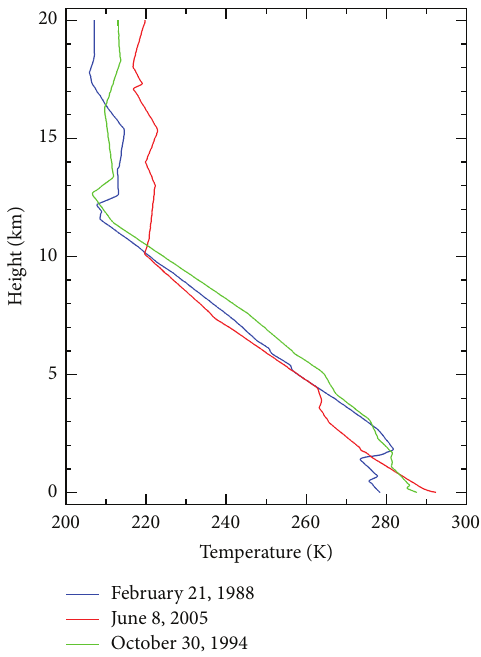
Figure 1: Three temperature profiles recorded at the San Pietro Capofiume station on different days indicated in the